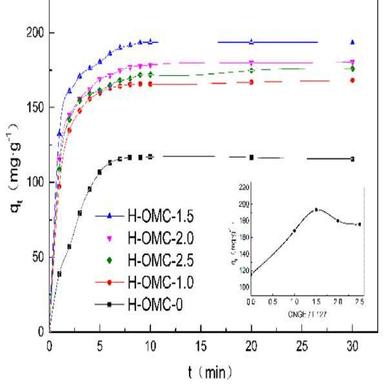
Adsorption of minocycline on H-OMC-X mesoporous carbon materials. Fig. 5. The effect of temperature on adsorption.